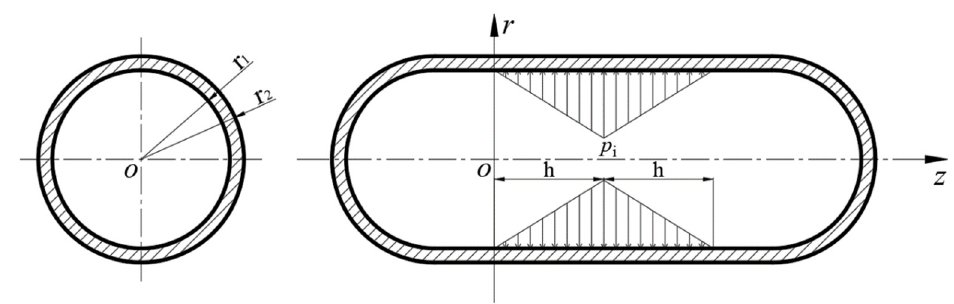
Figure 2. Model of a cylindrical shell and its spindle-shaped loadings.